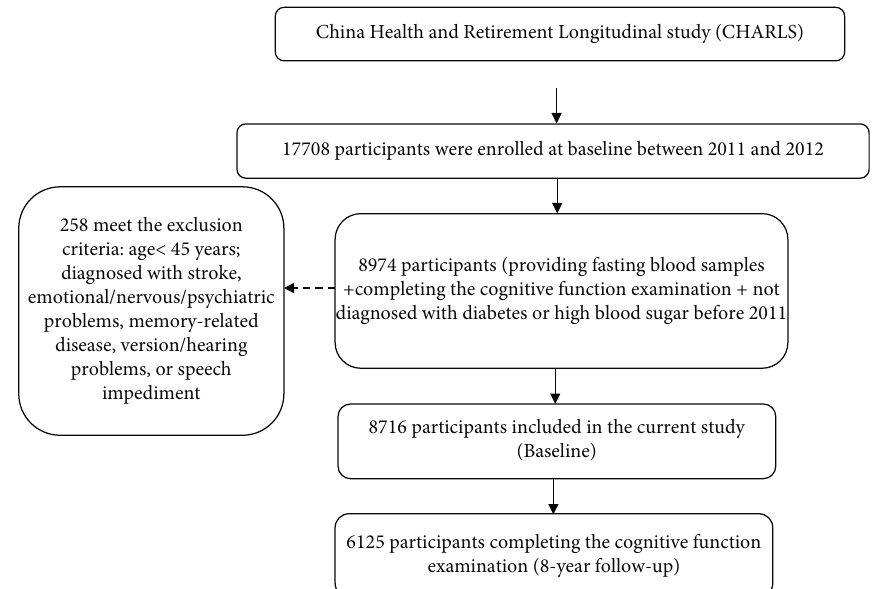
Figure 1: Flowchart of the study using data from the China Health and Retirement Longitudinal